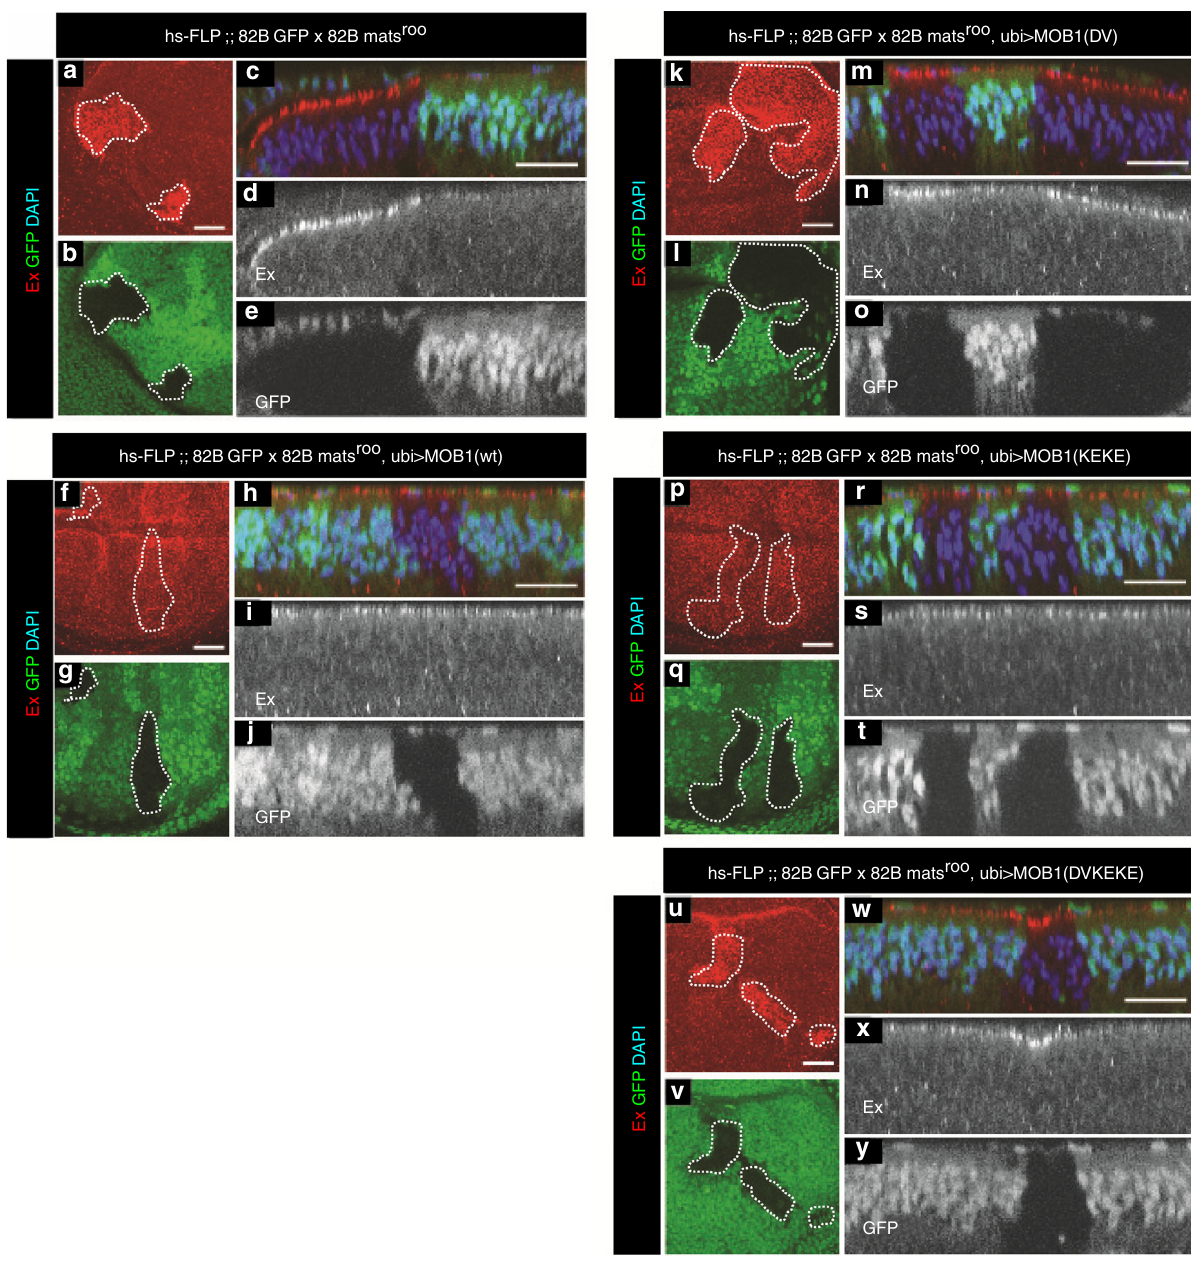
Fig. 6 Human MOB1(wt) or MOB1(K104/K105E), but not MOB1(D63V) or MOB1(D63V/K104E/K105E), expression suppresses elevated Yki activity in mats null mutant wing imaginal disk clones. Analysis of Ex expression in wing imaginal disks of the indicated genotypes ( wt wild-type, DV D63V, KE K104E/ K105E, DVKE D63V/K104E/K105E). All panels show third instar wing imaginal disks containing mats mutant clones marked by the absence of GFP expression ( green in b , g , l , q , v ). GFP-negative mats null clones are indicated by dashed lines . Maximum intensity projections of XY confocal stacks are shown in red to visualize Expanded ( Ex ) labeling ( red in a , f , k , p , u ). X – Z confocal sections through the same wing imaginal disks were acquired c , h , m , r , w . Nuclei are stained with DAPI in blue. Ex ( d , i , n , s , x ) and GFP ( e , j , o , t , y ) protein levels are indicated. All scale bars are 20 µ m. As expected, mats null clones displayed increased Yki activity as judged by elevated Ex levels a – e . Expression of MOB1(wt) f – j or MOB1(K104E/K105E) p – t suppresses Yki activity to normal levels in mats mutant clones (compare i , s with d ), while expression of MOB1(D63V) k – o or MOB1(D63V/K104E/K105E) u – y does not (compare n , x with d and i